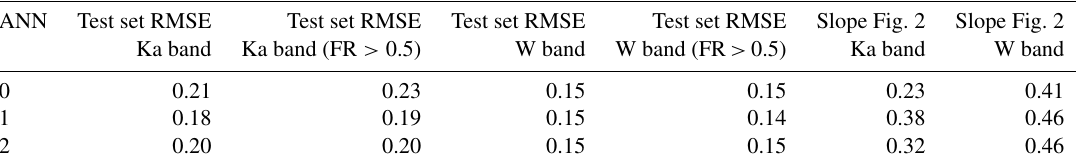
Slope Fig. 2 Slope Fig.